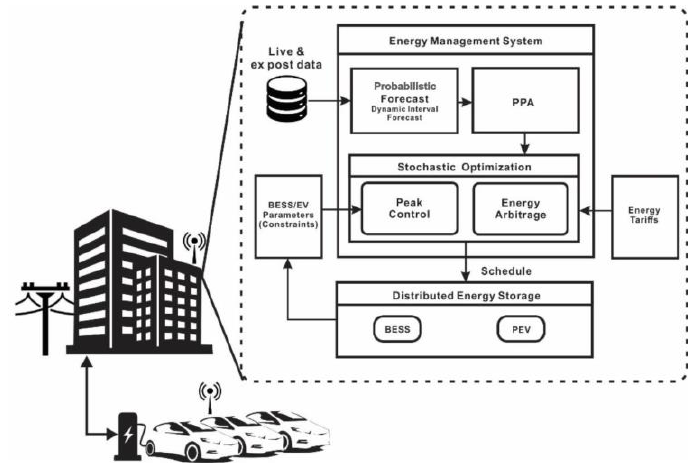
Figure 4. Proposed system architecture.